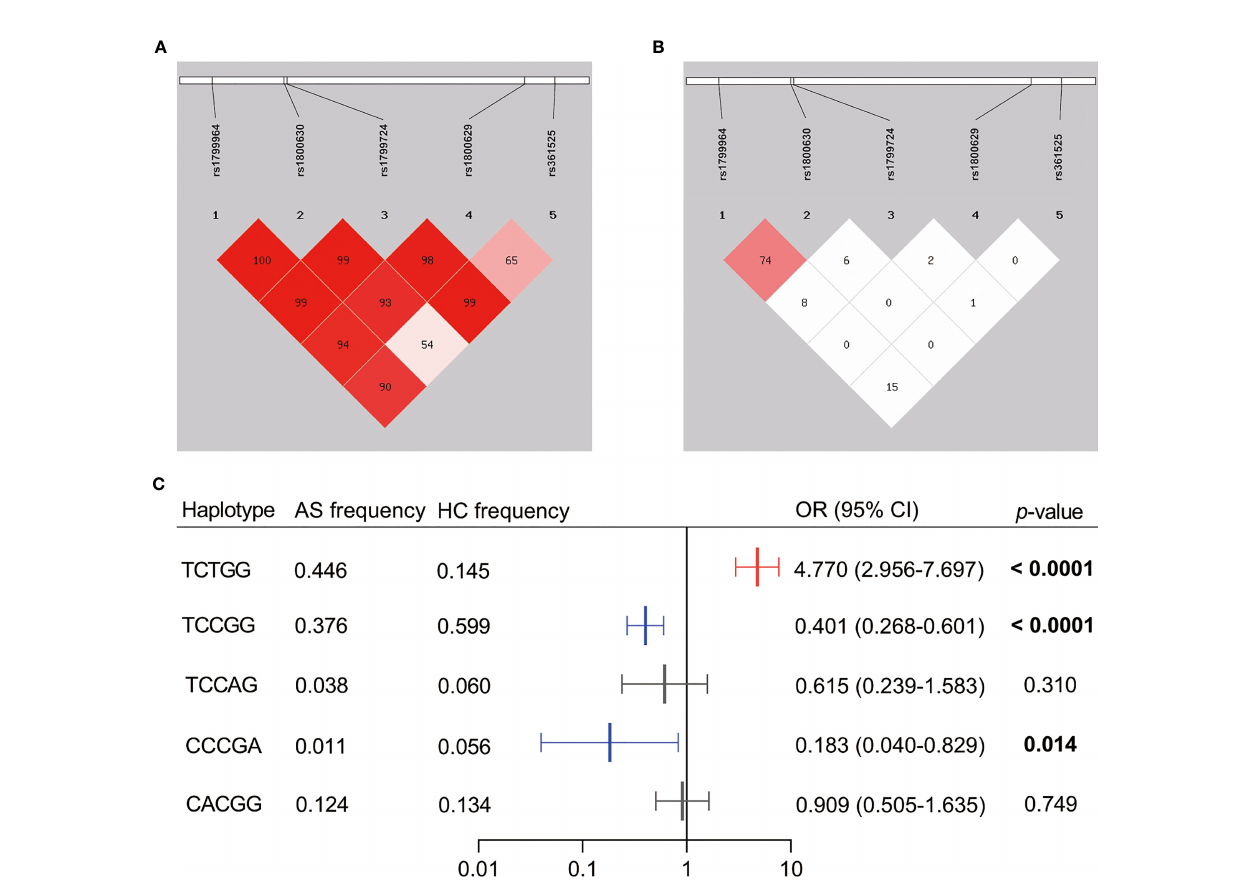
FIGURE 1 | Linkage disequilibrium (LD) pattern and haplotype analysis of the fi ve SNPs genotyped in TNF a . (A) The plot shows D ’ values in percentage as a pairwise measure of LD. (B) The plot shows r 2 values in percentage as a pairwise measure of LD. (C) Haplotypes were constructed by rs1799964, rs1800630, rs1799724, rs1800629, and rs361525. Dark shading indicates strong LD. The haplotype analysis was omitted if the frequencies were less than 0.03. AS, ankylosing spondylitis patients; HC, healthy control; OR, odds ratio; CI, con fi dence interval. The bold value showed the signi fi cance level less than